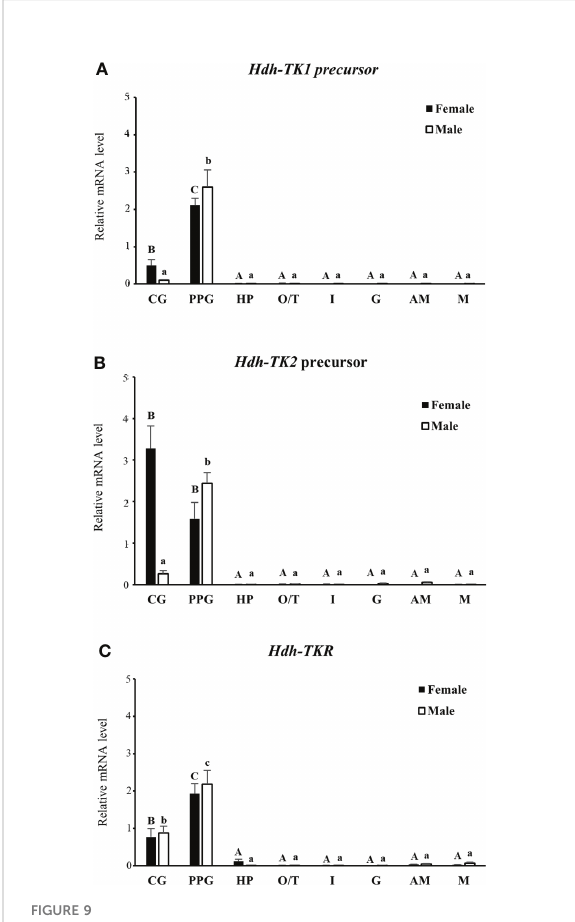
FIGURE 9 Tissue distribution of Hdh-TK precursors and Hdh-TKR transcripts in adult abalone. (A) Transcript levels of Hdh-TK1 and (B) Hdh-TK2 precursors, and (C) Hdh-TKR in female and male abalone were measured by real-time quantitative PCR. The ribosomal protein L-5 ( Hdh-RPL5 ) was used as the internal control. All data represent the mean ± SEM (n = 6). Different upper and lower case letters on the bars indicate statistically signi fi cant differences (p < 0.05). CG, cerebral ganglion; PPG, pleuro-pedal ganglion; HP, hepatopancreas; O, ovary; T, testis; I, intestine; G, gills; AM, adduct muscle; M,